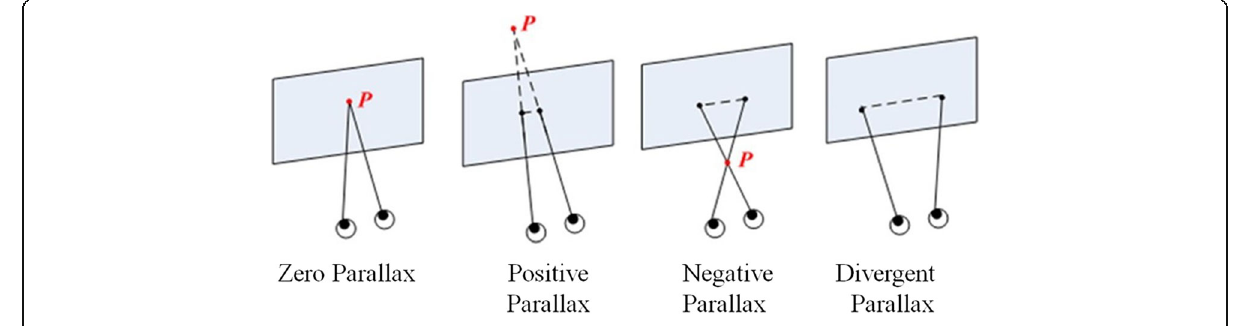
Fig. 1 Stereo perception based on the different parallax [24]